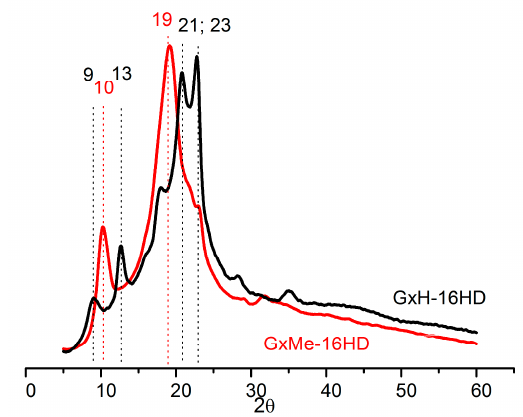
Figure 8. Wide-Angle X-ray Diffraction (WAXD) spectra of GxMe-16HD and GxH-16HD after pre-annealing at 75 °C.